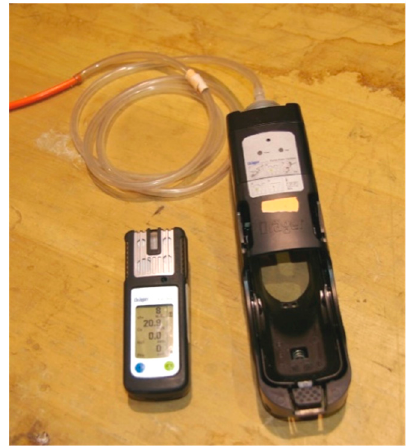
Figure 2. Photograph of Dräger X-am 5000 hand-held meter and air sample tubing.